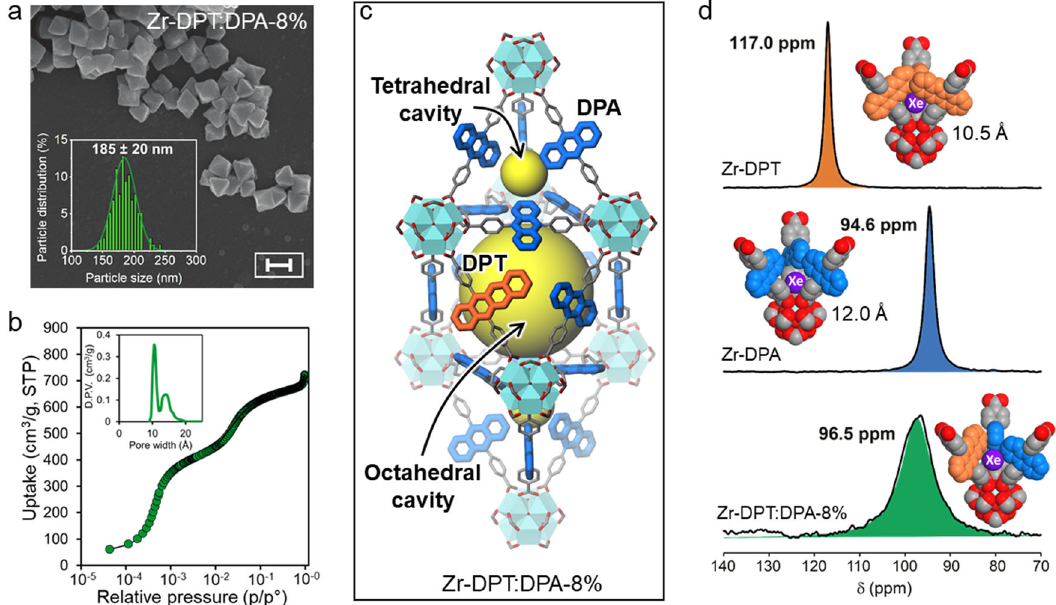
Fig. 2 Structural properties of hetero -ligand zirconium-based metal-organic framework (MOF) nanocrystals. a Scanning electron microscopy image of MOF nanocrystals realized with a content of molar DPT fraction of 8% (Zr-DPT:DPA-8%). The inset reports the distribution of MOF size (Scale bar: 200 nm). b N 2 adsorption isotherm collected at 77 K. The inset showed the pore size distribution with two distinct cavities of 10.8 Å and 14.5 Å. c Crystal structure of Zr-DPT:DPA highlighting the tetrahedral and octahedral cavities (yellow spheres). d Hyperpolarized laser-assisted 129 Xe NMR spectra of hetero -ligand nanocrystals compared with homo -ligand MOFs based on DPA and DPT. The spectra are fi tted with a Lorentzian line-shape function (colored areas) for quantitative